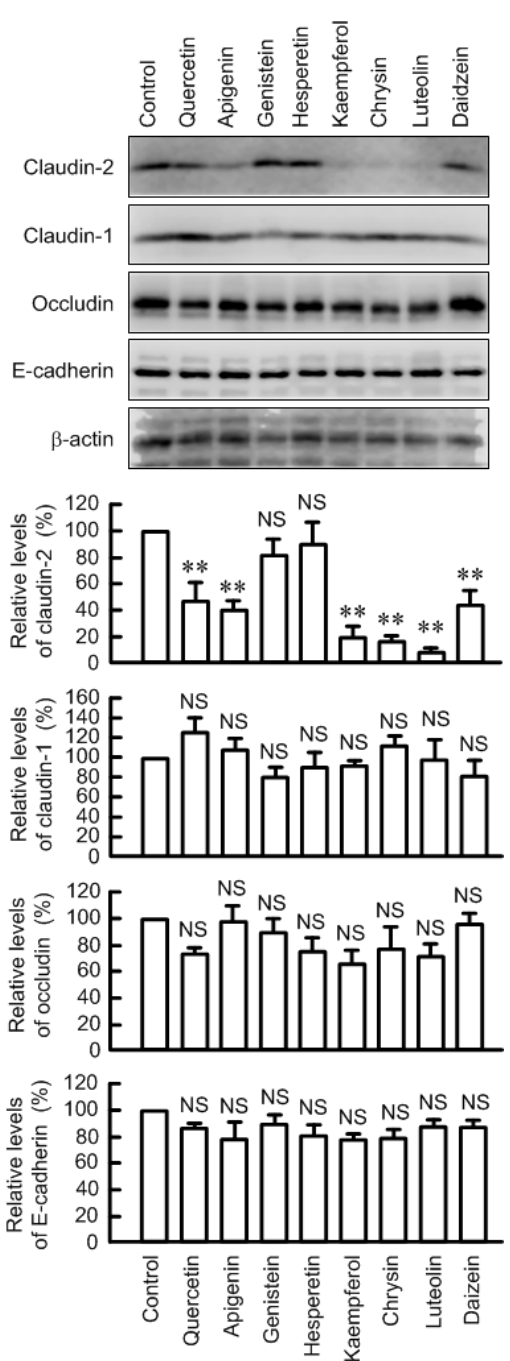
Figure 1. Effects of flavonoids on expression of junctional proteins in A549 cells. Cells were incubated in the absence and presence of 50 μ M flavonoids including quercetin, apigenin, genistein, hesperetin, kaempferol, chrysin, luteolin, and daidzein for 24 h. Cell lysates were immunoblotted with anti-claudin-2, anti-claudin-1, anti-occludin, anti-E-cadherin, or anti- β -actin antibody. The expression levels were represented relative to the values in control. n = 3–4. ** p < 0.01 significantly different from control. NS, not significantly different.